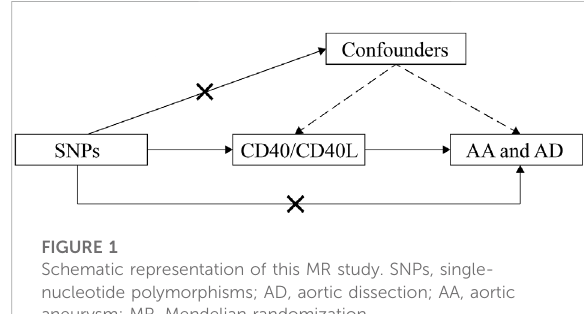
FIGURE 1 Schematic representation of this MR study. SNPs,